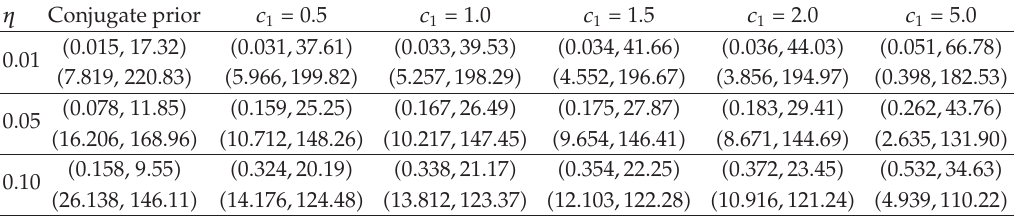
Table 4: Bayesian predictive and HPD predictive intervals for future observation of the data